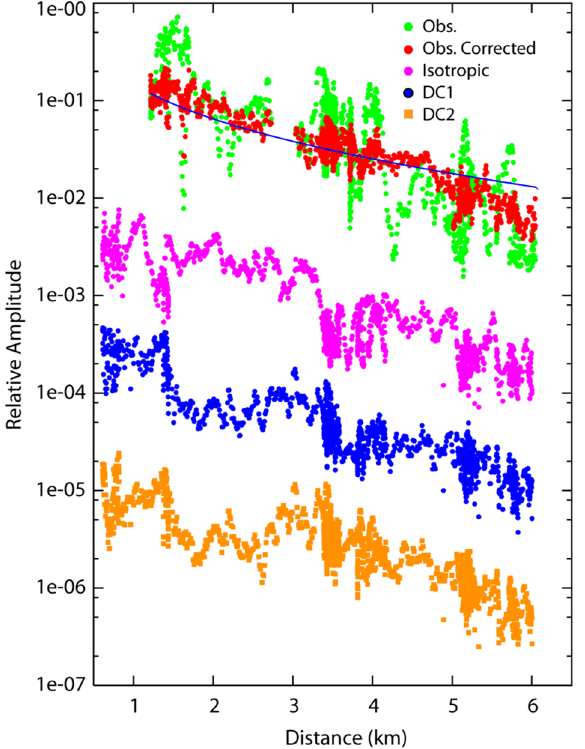
Figure 5. Comparison of the observed and theoretical amplitudes predicted for the best location for the July 4 earthquake. Green and red circles indicate the observed amplitude of dynamic strains and site factor corrected amplitudes, respectively. The black line indicates the theoretical prediction for the best location. Purple, blue, and orange symbols indicate theoretical amplitudes calculated by numerical simulations using an isotropic mechanism and two kinds of double-couple source mechanism. The theoretical amplitudes are shifted so as not to overlap each